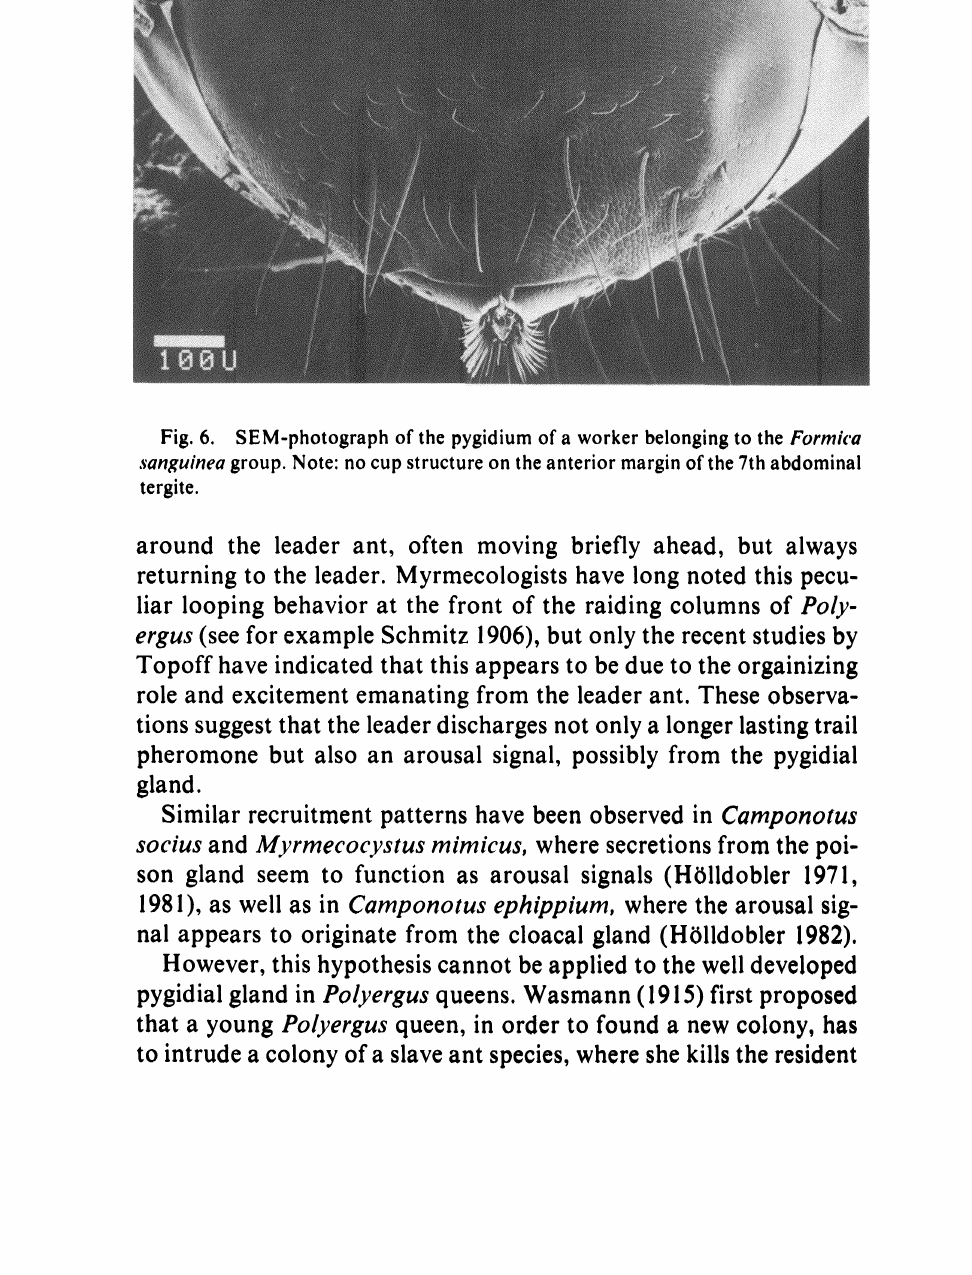
Fig. 6. SEM-photograph of the pygidium of a worker belonging to the Formica sanguinea group. Note: no cup structure on the anterior margin of the 7th abdominal